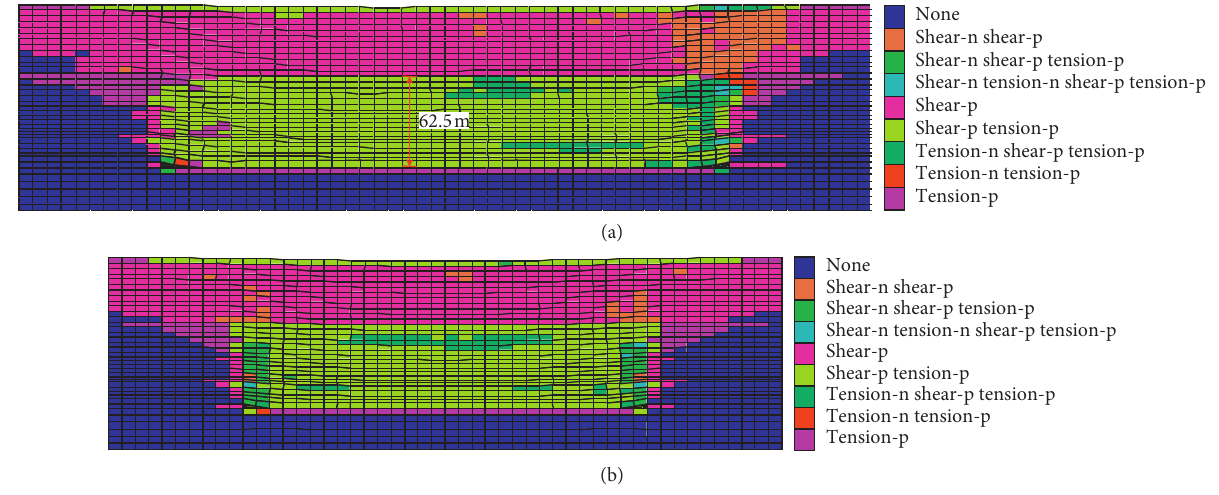
Figure 13: Overburden damage caused by coal seam mining. (a) y � 250m. (b) x � 300m.